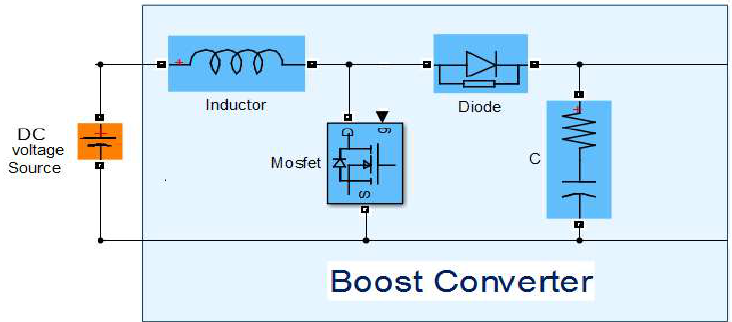
Figure 6. Circuit diagram of a DC-DC converter.